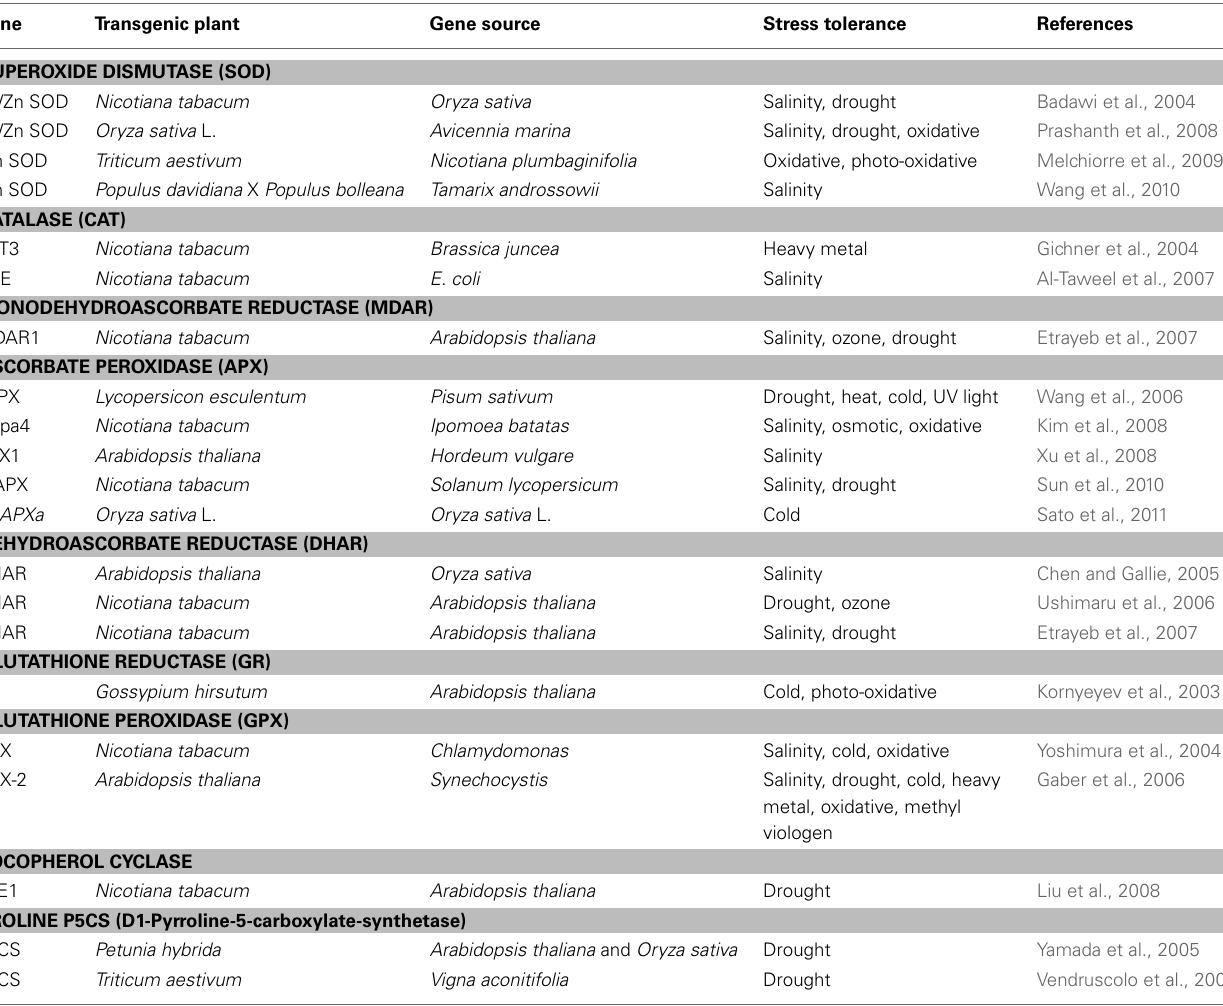
tabacum . Co-expression of maize ZmCu/ZnSOD and